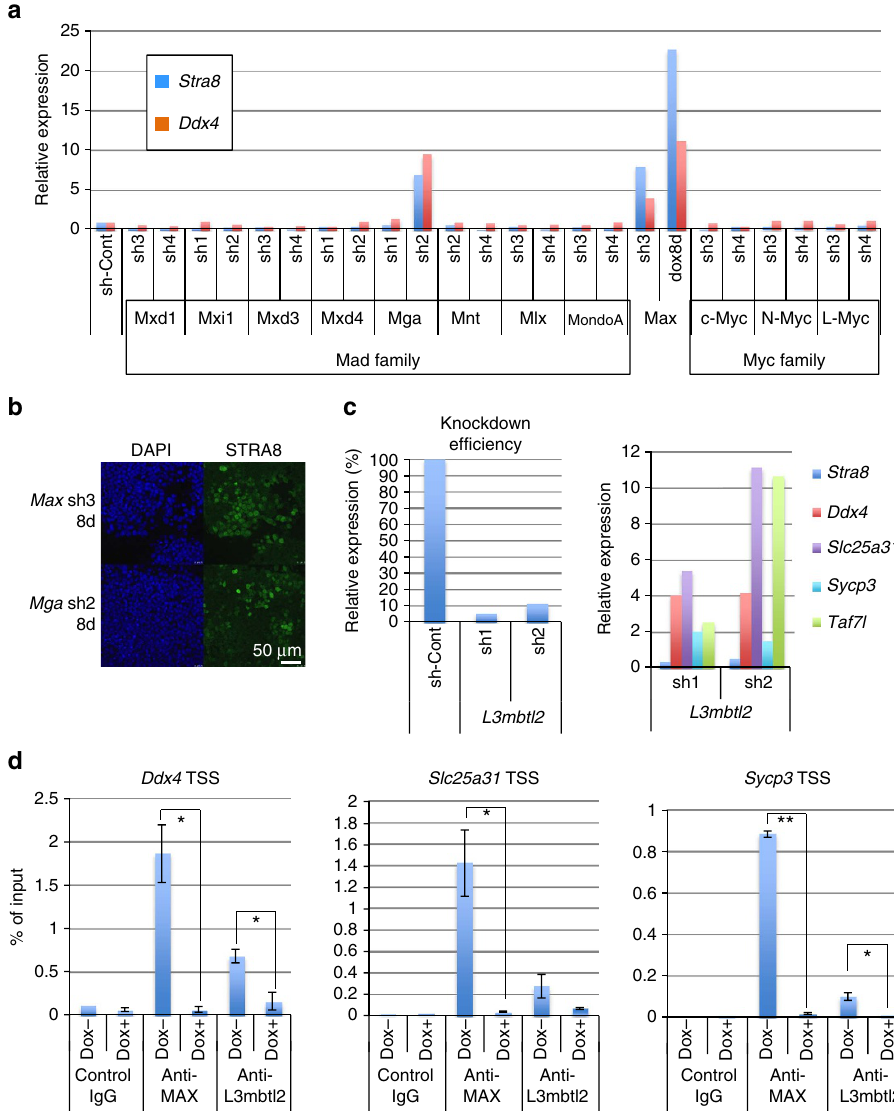
Figure 7 | Implication of the MAX-containing PRC1.6 complex in the blockade of meiosis-related gene expression in ESCs. ( a ) Effect of knockdown of Myc superfamily genes on the expression of Stra8 and Ddx4 genes in ESCs. Expression levels of Stra8 and Ddx4 genes were quantitated in Dox-untreated Max -null ESCs subjected to lentivirus-mediated stable knockdown of the indicated genes. Expression levels of Stra8 and Ddx4 genes in cells subjected to knockdown with a scrambled sequence was arbitrarily set to one. Knockdown efficiency of each gene is shown in Supplementary Fig. 10a. ( b ) Immunocytochemical analyses of STRA8 in Dox-untreated Max -null ESCs in which expression of Max (upper) and Mga (lower) was subjected to lentivirus-mediated stable knockdown. ( c ) Effect of L3mbtl2 knockdown on meiotic gene expression in ESCs. Lentivirus-mediated knockdown was conducted as described in a. Expression of Stra8 , Ddx4 , Slc25a31 , Sycp3 and Tafl7 was determined by TaqMan-based quantitative PCR. ( d ) ChIP analyses of meiotic gene promoters with antibodies against MAX and L3MBLT2. Dox-untreated and -treated Max -null ESCs for 4 days were subjected to ChIP with either anti-MAX or L3MBLT2 antibodies. A ChIP reaction was also performed with control IgG. The genomic DNAs recovered by these ChIP reactions were individually subjected to quantitative PCR to quantify the relative amounts of Ddx4 , Slc25a31 and Sycp3 gene promoters compared with those used as input samples ( n ¼ 3, means ± s.d.). Unpaired t -test was done to compare immunoprecipitation efficiency statistically between Dox-untreated and -treated Max -null ESCs (* P o 0.05; ** P o